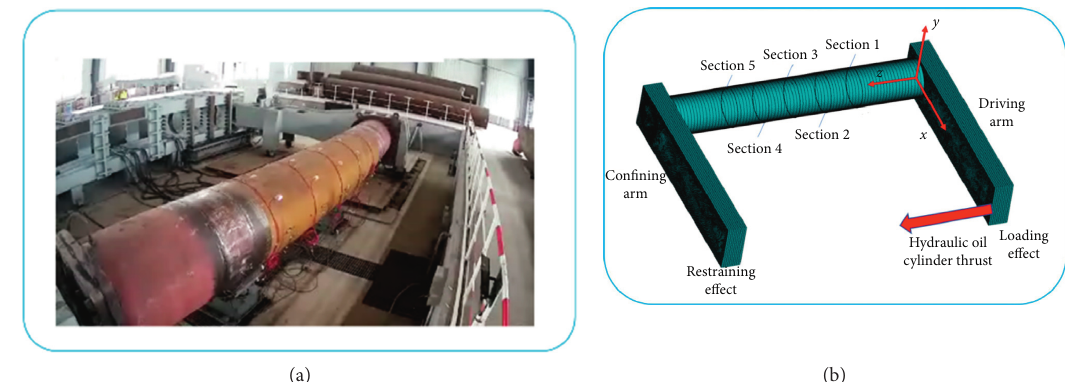
Figure 2: A large-scale mechanical loading experiment combined with FEM establishment: (a) large-scale mechanical loading experiment; (b) FEM establishment.